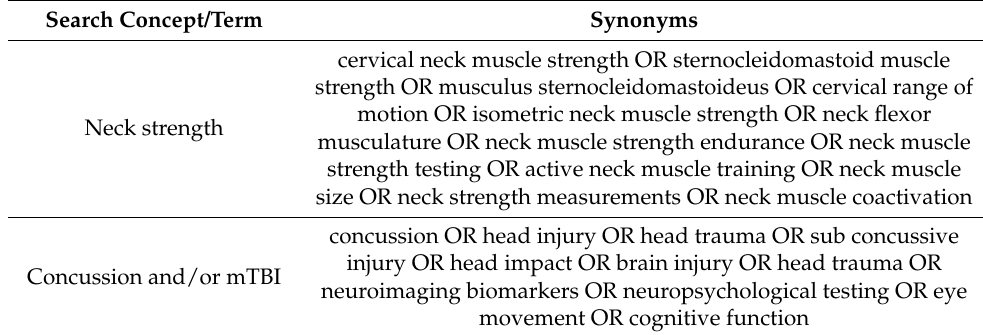
Table 1. Sample search strategy